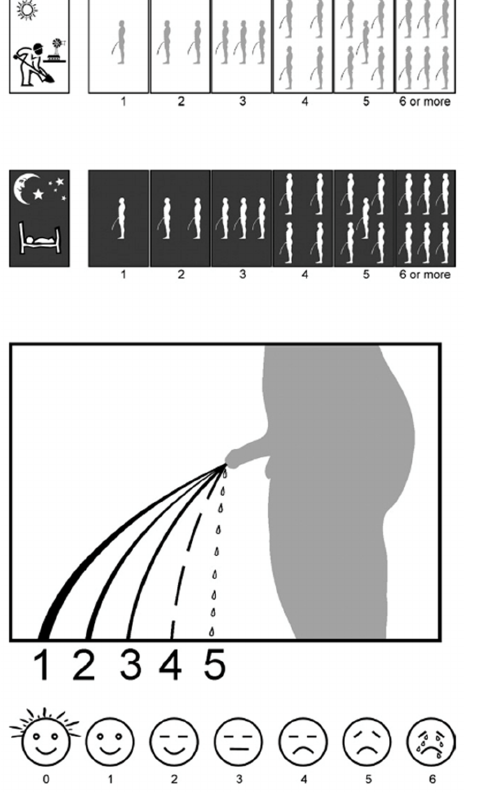
Figure 2. Visual Prostate Symptom Score (VPSS) [9]. Dutch translation of “6 or more”: “6 of meer”.